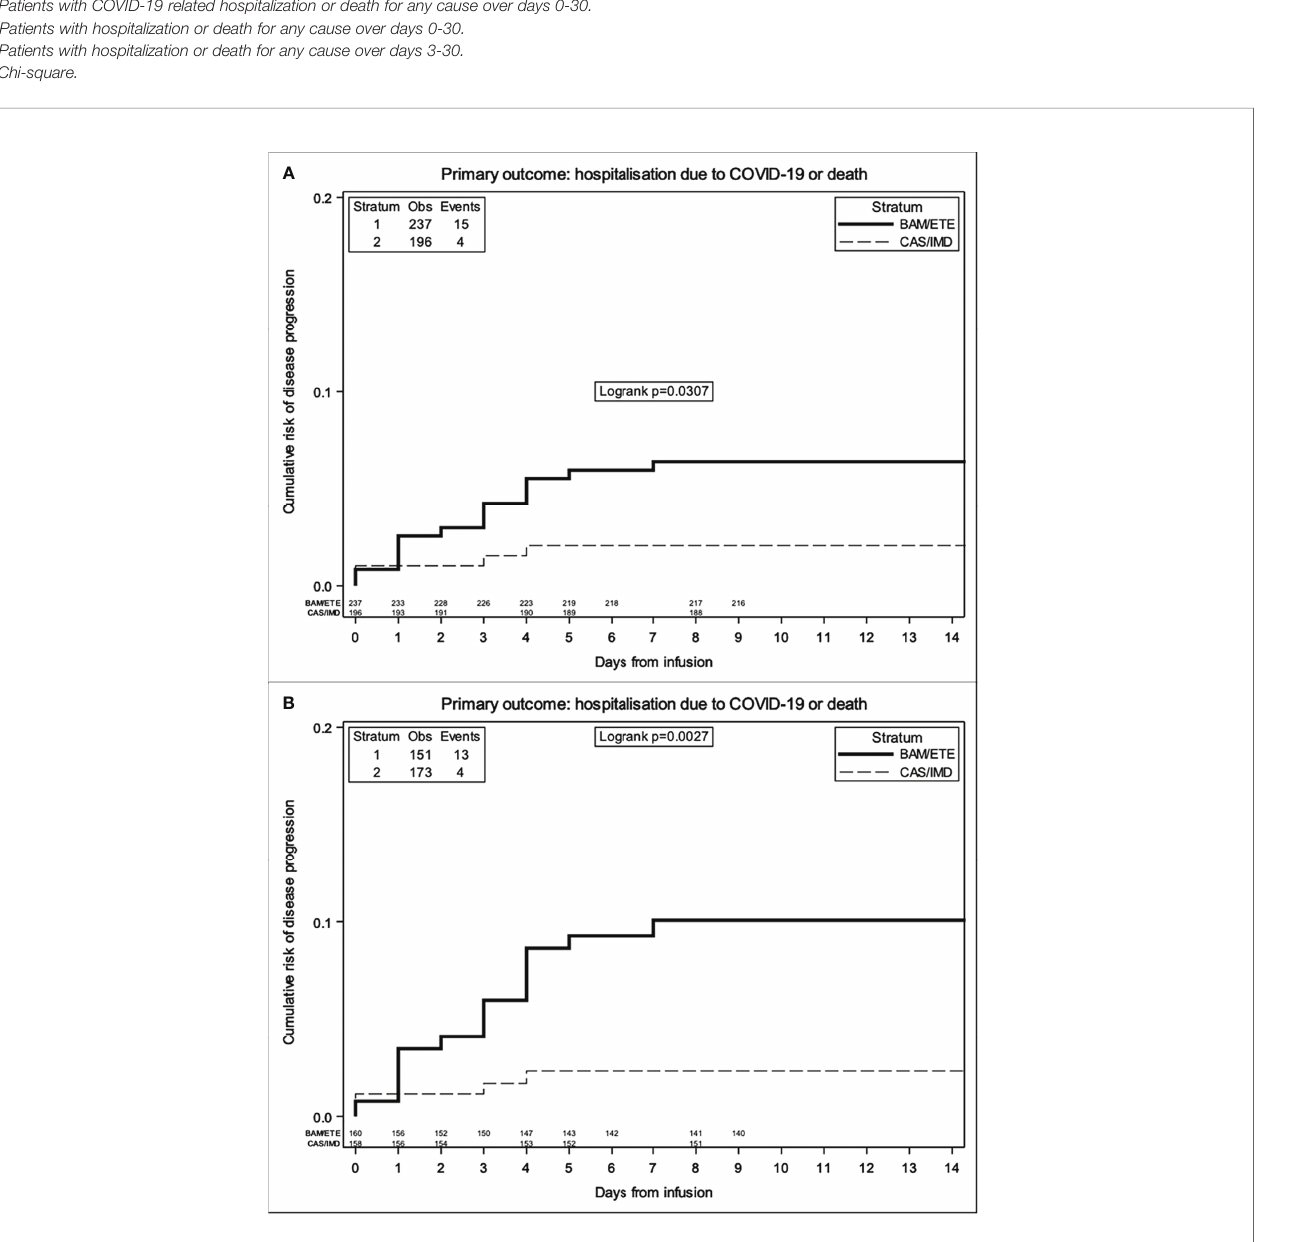
FIGURE 3 | Unweighted (A) and Weighted (B) Kaplan Meier curves of time to primary endpoint by intervention group -weights include month of enrolment and type of VoC.